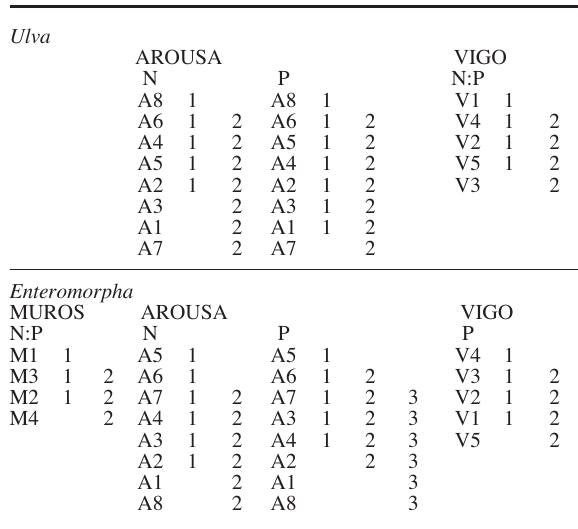
ABLE 5. – Groups established for nutrients in Ulva and Enteromorpha for each ría, using the Tukey-HSD multiple compar- isons test. The sites are ordered by increasing mean concentration of the corresponding nutrient. Sampling sites with the same group- ing number were not significantly different. In cases where no groups appear, no significant differences were